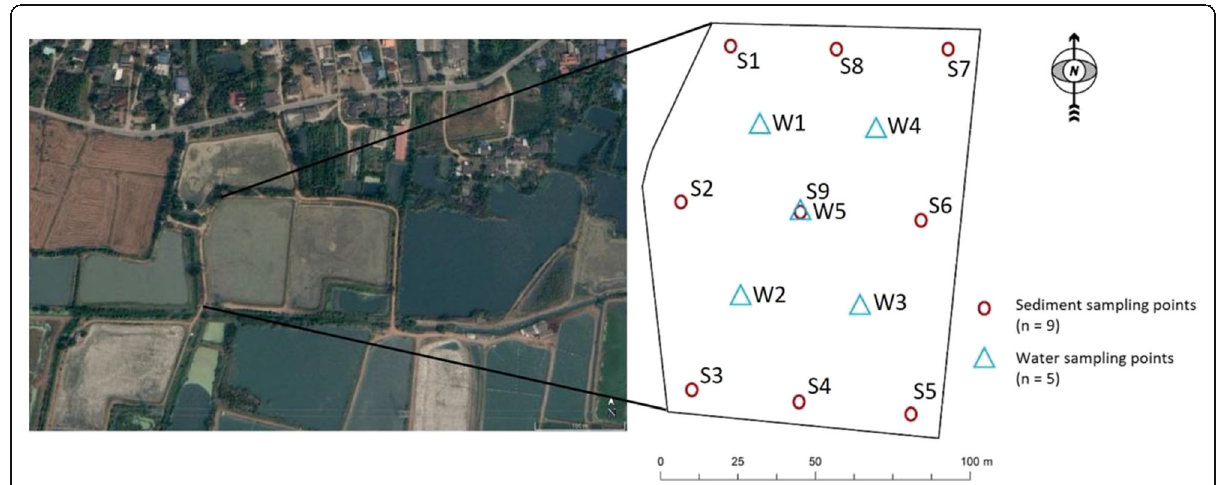
Fig. 1 Map of shrimp farm study area with water and sediment sampling